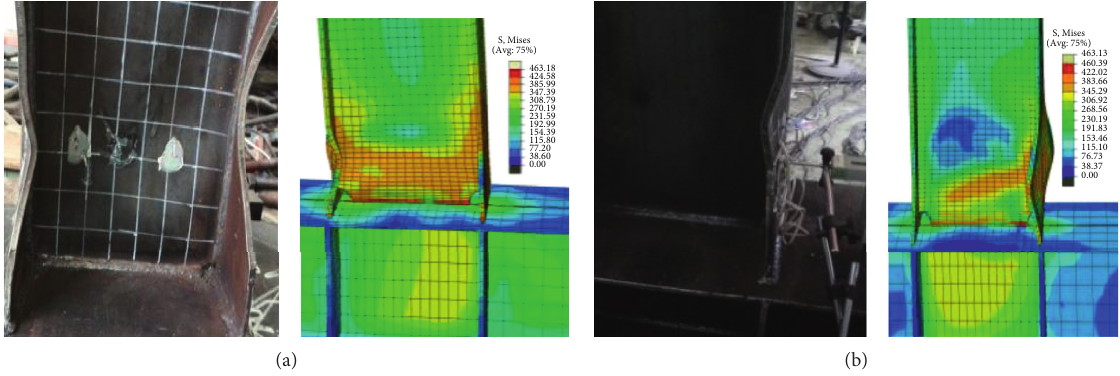
Figure 4: Position of plastic hinge. (a) WF-1A and (b) WF-1B.